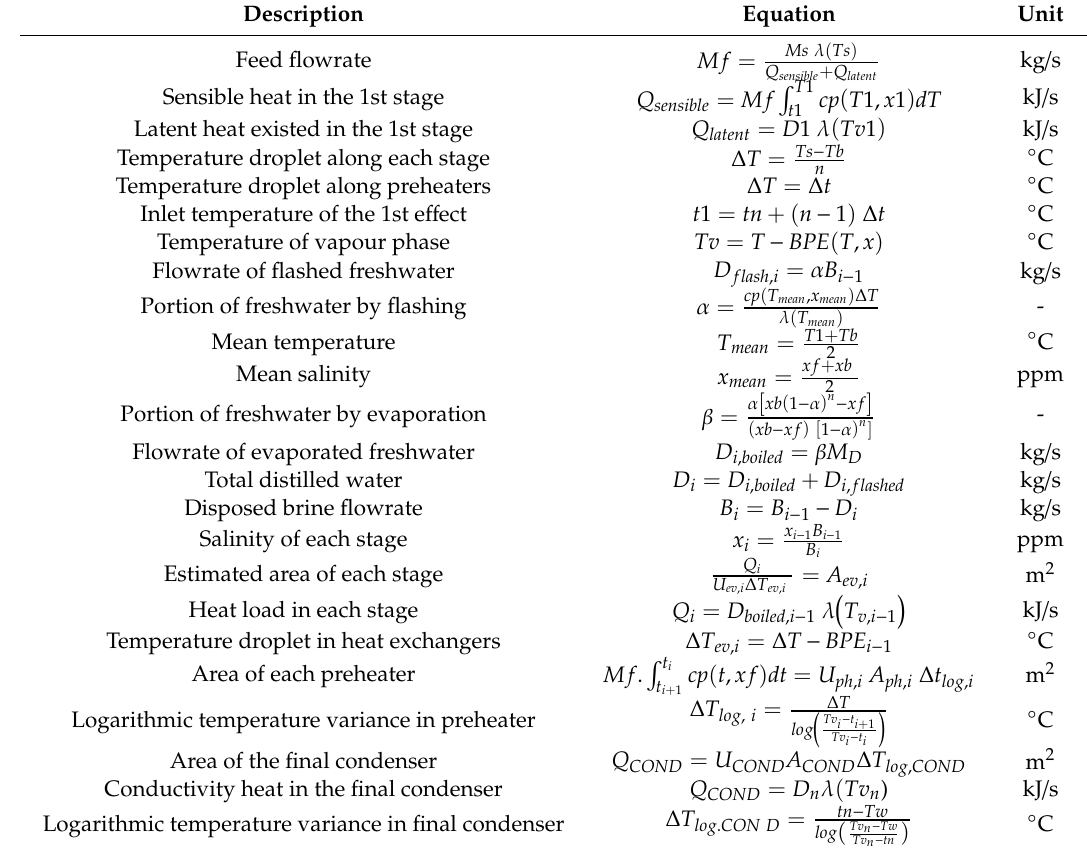
Table A1. Mathematical model of multi e ff ect distillation system